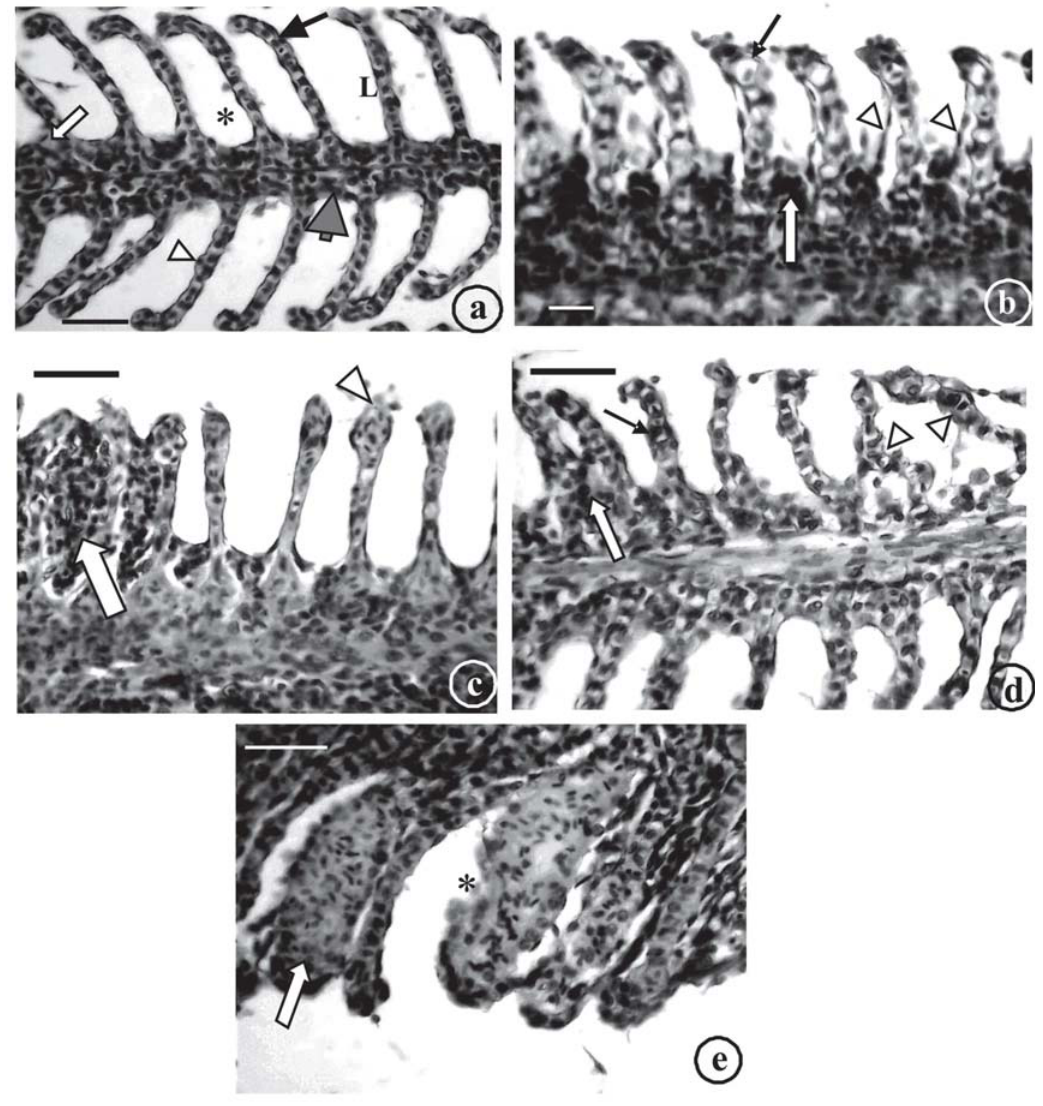
Fig. 2. Photomicrographs of the gill of P. lineatus caged in Cambé stream. a) normal aspect of the gill, showing the filament (gray arrow), the lamellae (L), the water channel (*), a pillar cell (black arrow) and an epithelial cell (arrowhead); b) lamellae with the marginal channel dilated (black arrow), hyperplasia of the epithelial cells (white arrow) and epithelial lifting (arrowheads); c) fusion of 3 lamellae (white arrow) and blood congestion (arrowhead); d) lamellar disorganization (arrowheads), partial fusion of some lamellae (white arrow) and hypertrophy of the lamellar epithelium (black arrow); e) lamellar aneurysm (white arrow) and epithelium rupture with hemorrhage (*). Scale bar 20mm,